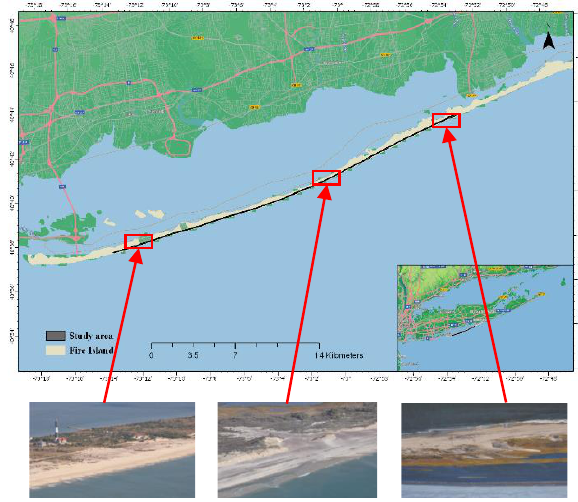
Figure 1. Study area Fire Island(Note: Map derived from ArcGIS Pro) and its three locations(Petersburg, 2015)